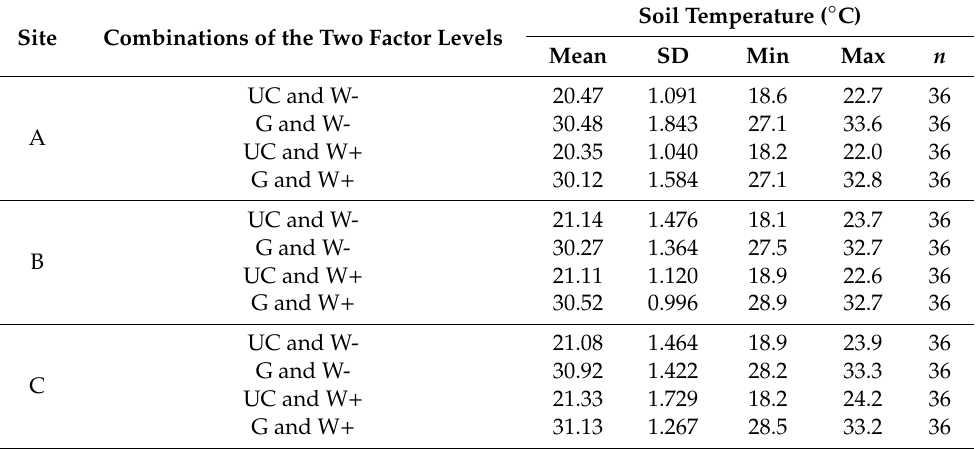
SD = Standard deviation, n = number of temperature measurements (three measurements for each plot × 12 plots = 36), UC and W- = under canopy without water supplementation, UC and W + = under canopy with water supplementation, G and W- = gap without water supplementation, G and W + = gap with water supplementation. Table 7. Soil temperature values for the period when the seed germination of ESP (end of February–March 2010) took place in the plots of each sowing environment in each of the three sites.